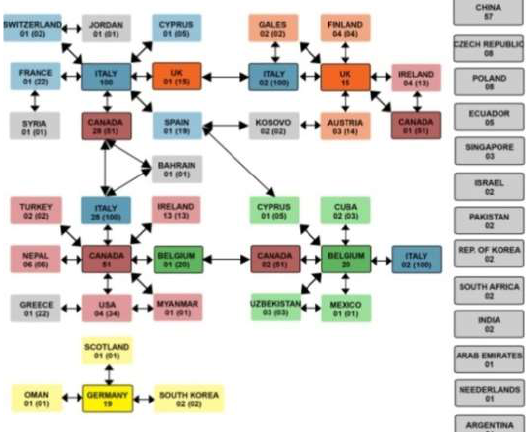
Figure 1: Interaction of foreign researchers by countries